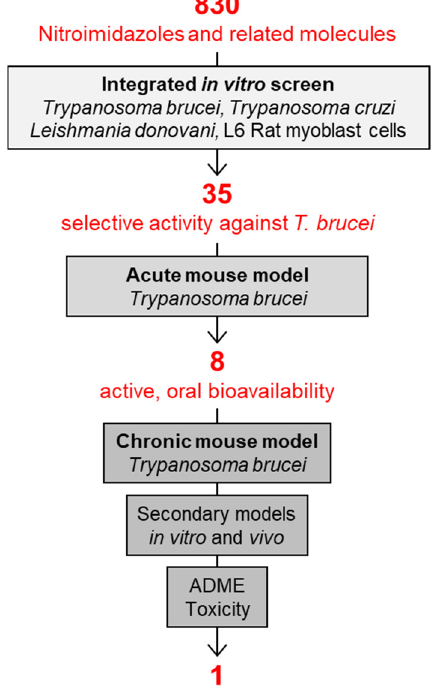
Figure 2. Nitro-drugs are a mainstay of antiprotozoal chemotherapy. The 5-nitroimidazole metro- nidazole is used for intestinal pathogens and trichomoniasis; the 2-nitroimidazole benznidazole for Chagas disease; the nitrofuran nifurtimox for Chagas and, in combination with eflornithine, for gambiense HAT.